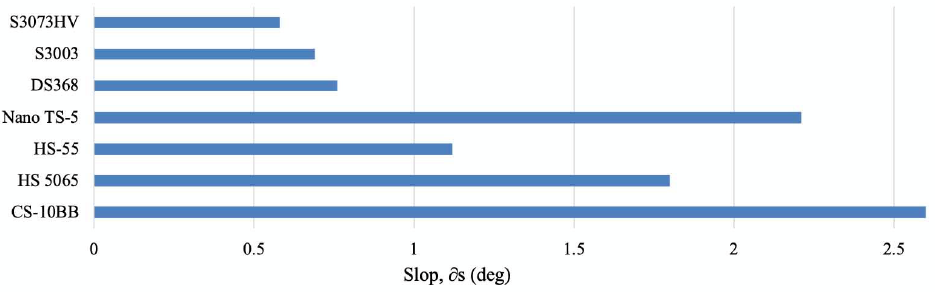
Figure 4. Conventional Subscale Servoactuator Slop.